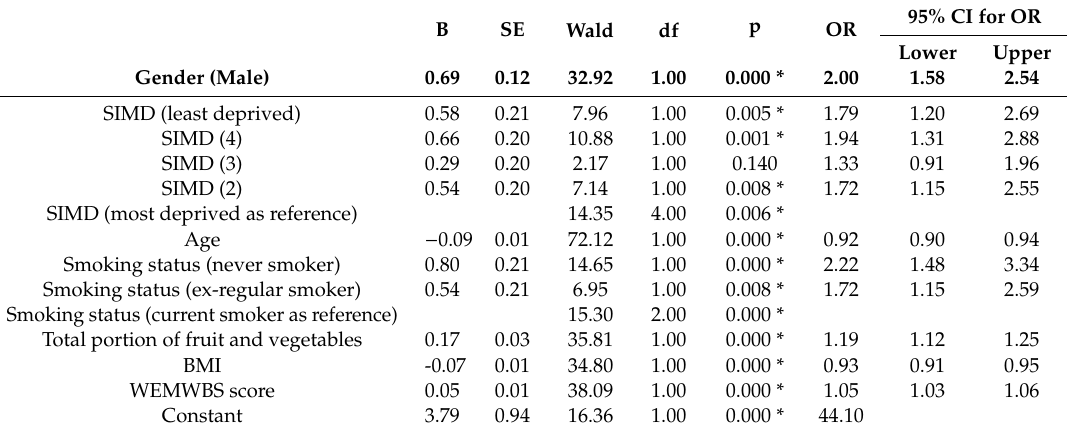
Table 5. Full details on binomial logistic